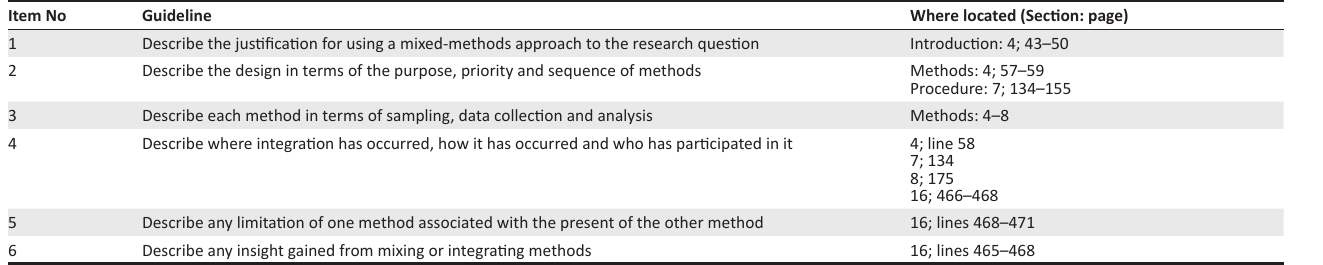
TABLE 1-A1: Good reporting of a mixed-methods study checklist of items. Item No